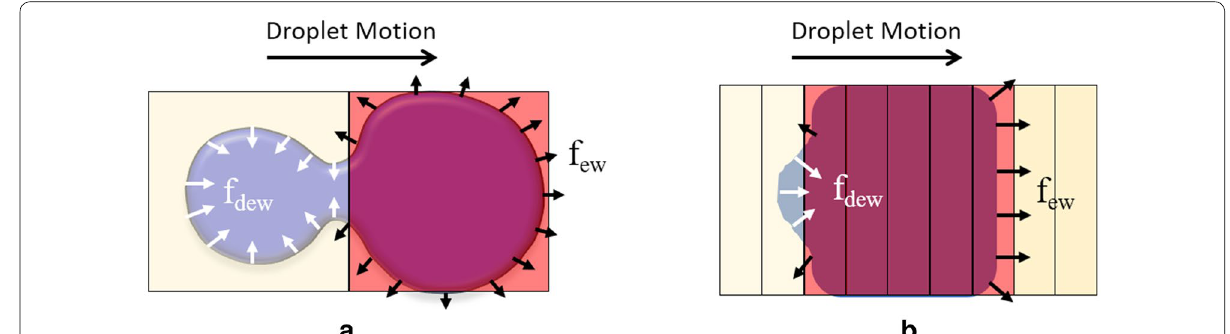
Fig. 2 A droplet during transition from a grounded electrode to an activated one (top view). Activated electrode is indicated in red. Electrowetting force, f ew (black arrows) and dewetting force, f dew (white arrows), on the triple point contact line are shown. a Droplet transition on square shape electrodes. b Droplet transition on rectangular electrodes with short width